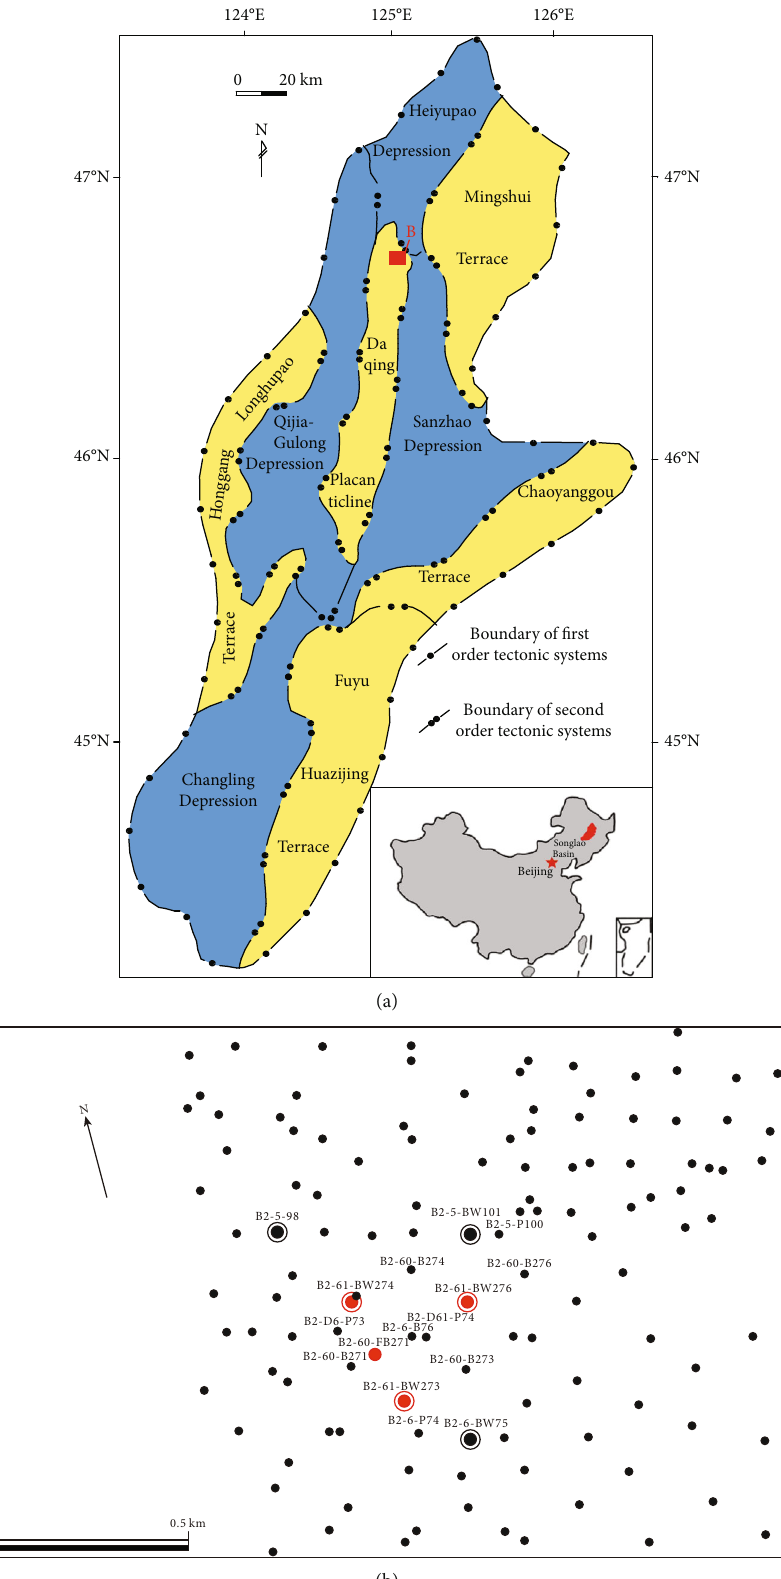
Figure 1: Map of the study area in the northeast of Daqing Placanticline in the Songliao Basin, eastern China. (a) Structural map of the Songliao Basin with the well locations. (b) Map of the developing well pattern of well